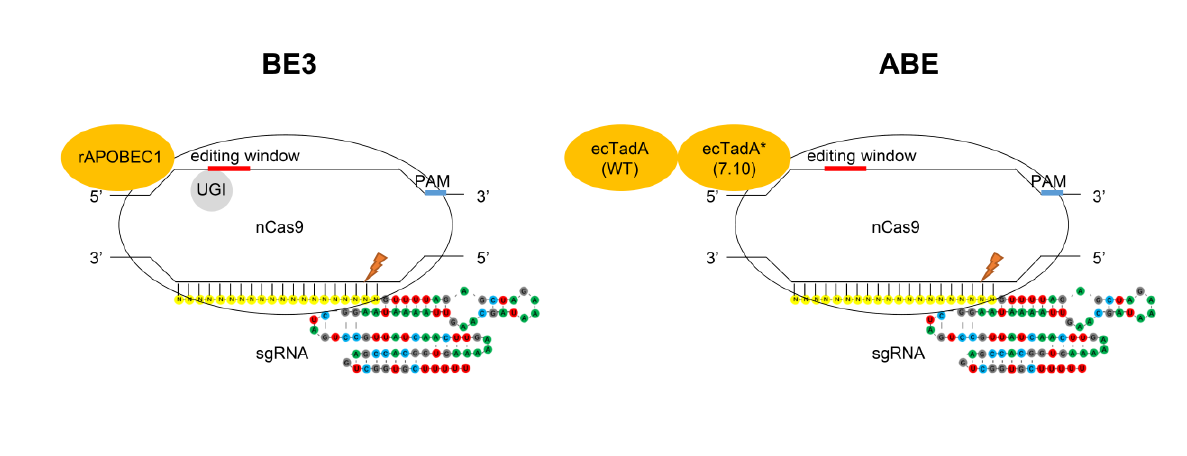
FIGURE 1: Targeted base substitutions without double strand break by cytidine- and adenine- deaminase. In these illustrations of base editing ， deaminase proteins are shown in orange. The base-editing windows are highlighted in red, and the PAM sequences in blue on the DNA strand. nCas9 indicates Cas9 nickase harboring D10A mutation. Left: BE3 composed of rAPOBEC1, nCas9 and UGI (uracil glycosylase inhibitor). rAPOBEC1 indicates cytidine deaminase APOBEC1 derived from rat. Right: ABE composed of ecTadA (WT)-ecTadA* (7.10) fusion and nCas9. ecTadA (WT) indicates natural adenine deaminase Escherichia coli TadA. ecTadA* (7.10) indicates Escherichia coli TadA variant after protein